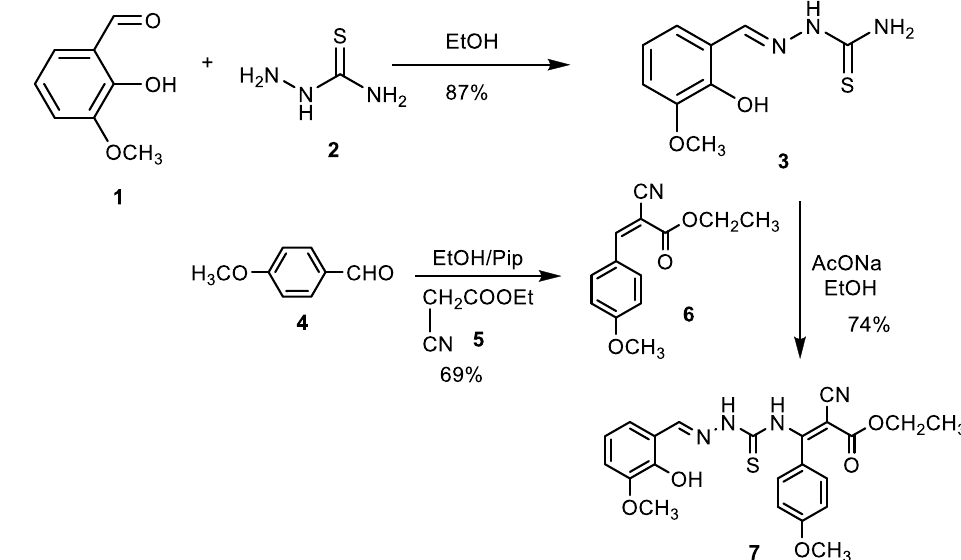
Figure 1. Reagents and conditions for the synthesis of the methoxy thiosemicarbazone (MTSC) ligand ( 7 ).